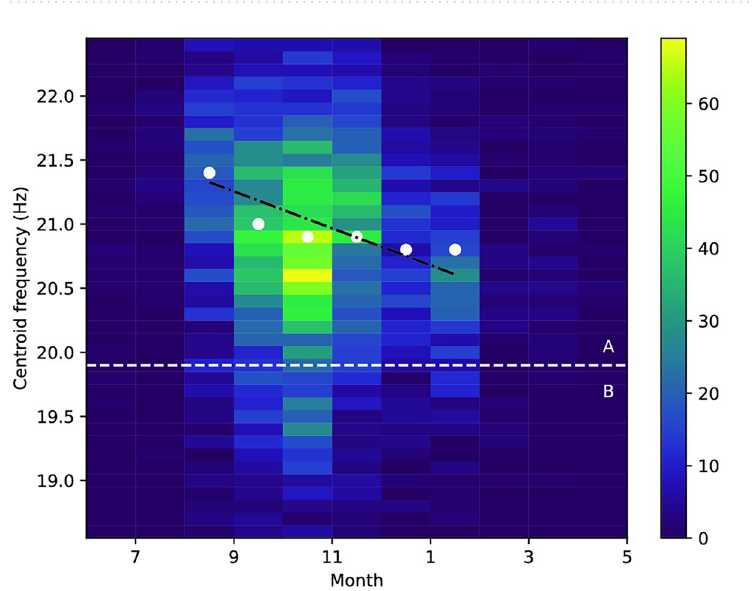
Figure 8. Bi-histogram of the center frequencies against months of the year. The horizontal line shows the separation between type A and type B pulses. The fitted linear model is shown as a black dashed